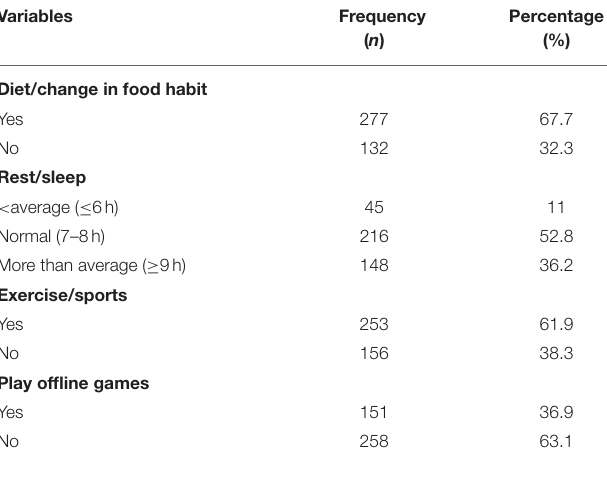
TABLE 3 | Health-related information of respondents.